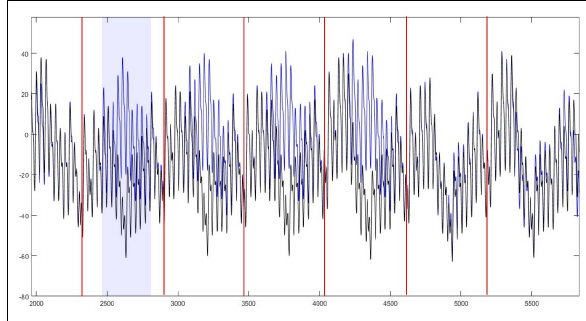
Figure 6. Part of a single execution of the algorithm. The black line is the power consumption trace when 6 is sampled, and red line is the power consumption trace when 2 is sampled. The blue area indicates the difference between the power consumption